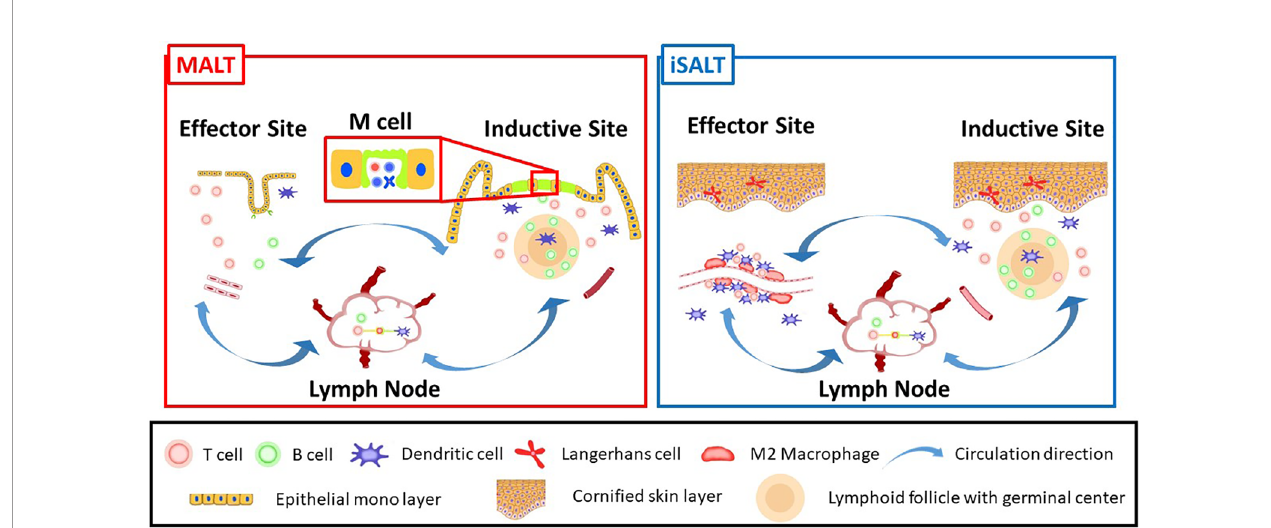
FIGURE 1 | A schematic model of iSALT corresponding to MALT concept: MALT (left) and iSALT (right) are consist of inductive site, effector site, and regional lymph nodes. The inductive site of MALT harbors lymphoid follicles termed as MALT structures which play pivotal roles to induce acquired immunity. M cells locate in the monolayer termed follicle-associated epithelium above MALT structures. Transient induction of lymphoid follicles immunohistochemically consistent with MALT structure is observed in the dermis beneath the corni fi ed epidermis in some human skin diseases, which correspond to inductive sites of iSALT although it is unknown if M cells co-localize. Effector site is an anatomically distant site which the differentiated B and T lymphocytes migrate to, from inductive site or regional lymph nodes. Thus, the effects of immune memory are exerted upon the antigens in effector site. Effector site of MALT is well-investigated for B cell lineage function such as IgA delivery to outside of epithelial monolayer through transcytosis. On the other hand, the phenomena observed in the mouse CHS model suggest the effector site of iSALT where CD8+ T cells, M2 macrophages, and dendritic cells adjacent to blood vessels are essential to activate effector T cells. Langerhans cells are also known as a regulator of in fl ammation. Lymphocytes differentiated in iSALT are considered to circulate within a limited area of anatomical sites, namely the skin (Circulation directions are indicated by arrow in the fi